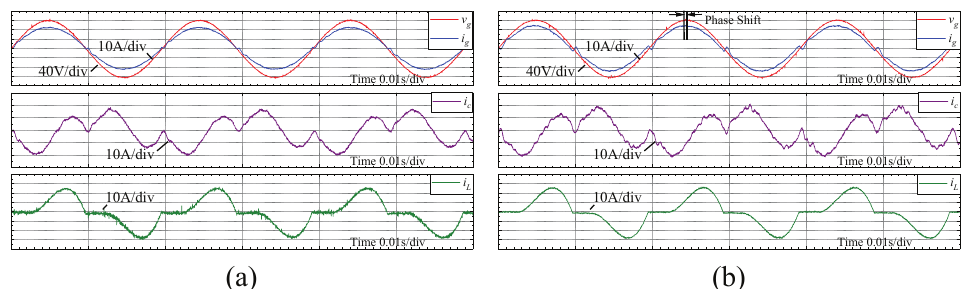
Figure 16. The current waveform at 49 Hz when different controllers are used. ( a ) the proposed RC. ( b ) CRC.